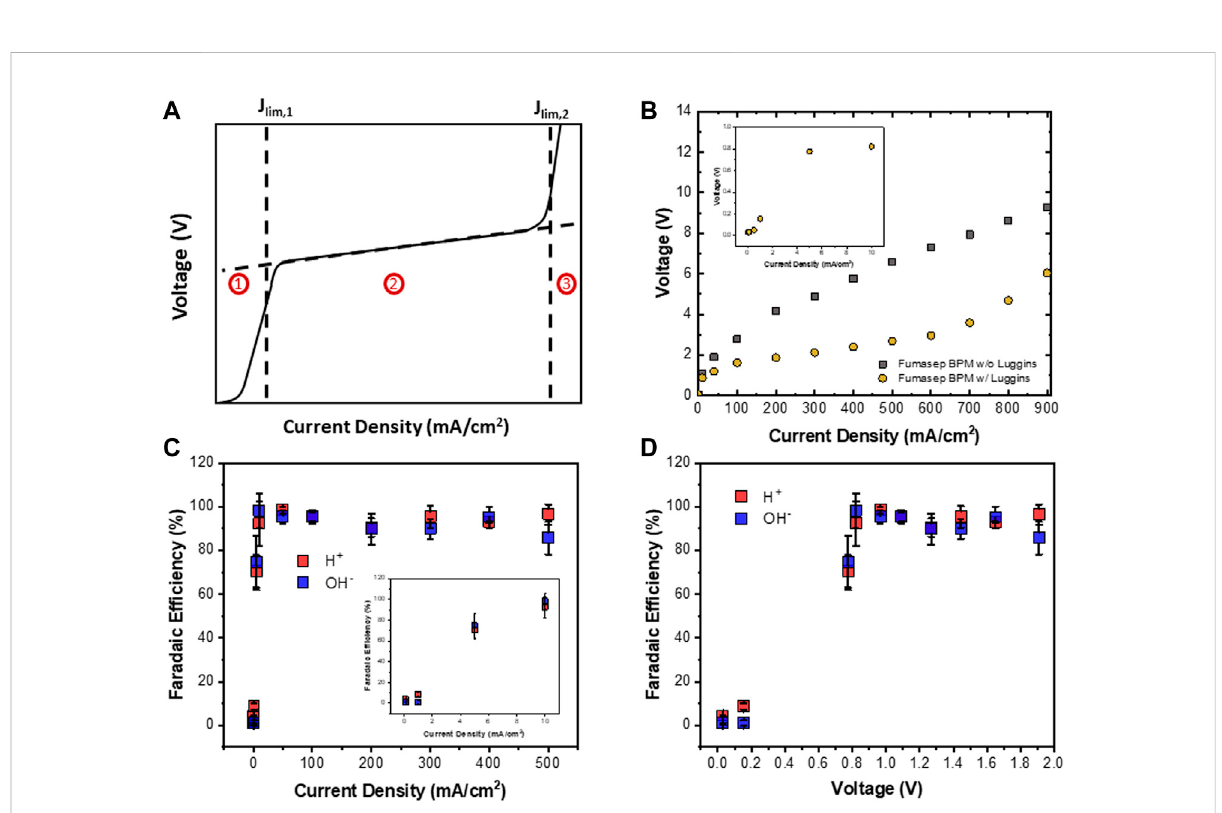
FIGURE 3 Typical current voltage pro fi le for abipolar membraneunder reverse bias (A) . Current-voltage (B) , Faradaic ef fi ciency ofH + and OH − vs. current density (C) ,and Faradaicef fi ciencyofH + and OH − vs.voltage (D) plots foracommercial Fumasep bipolarmembranetested incustom electrodialysis fl ow cell ( fl ow rate: 1